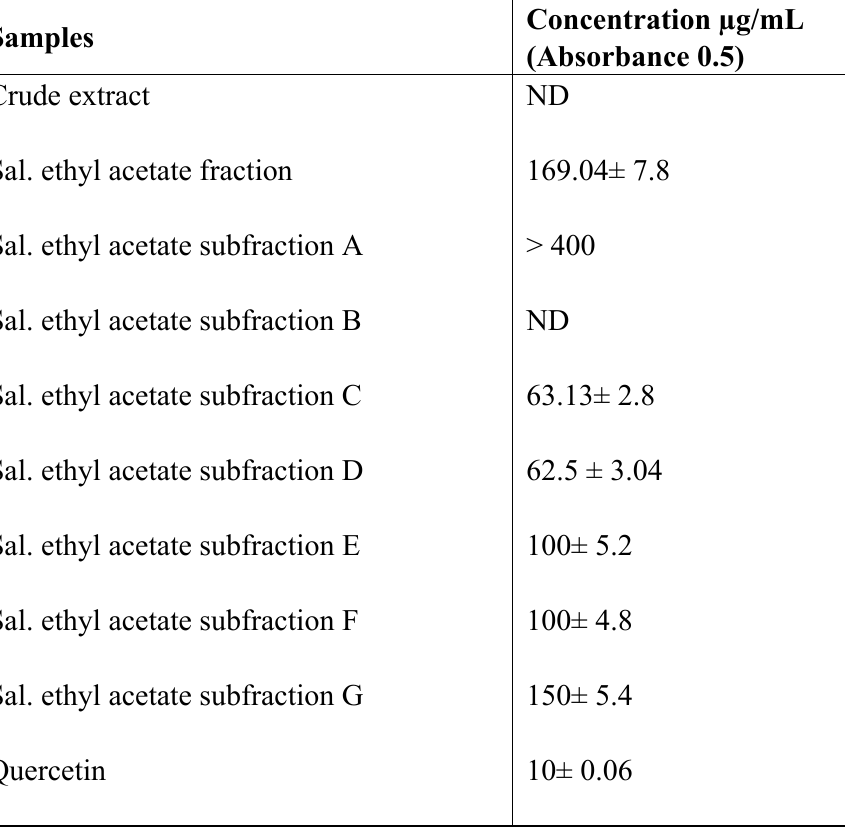
Table 1: Concentration of Salvia mirzayanii subfractions at absorbance 0.5 compared with quercetin as standard in reducing power